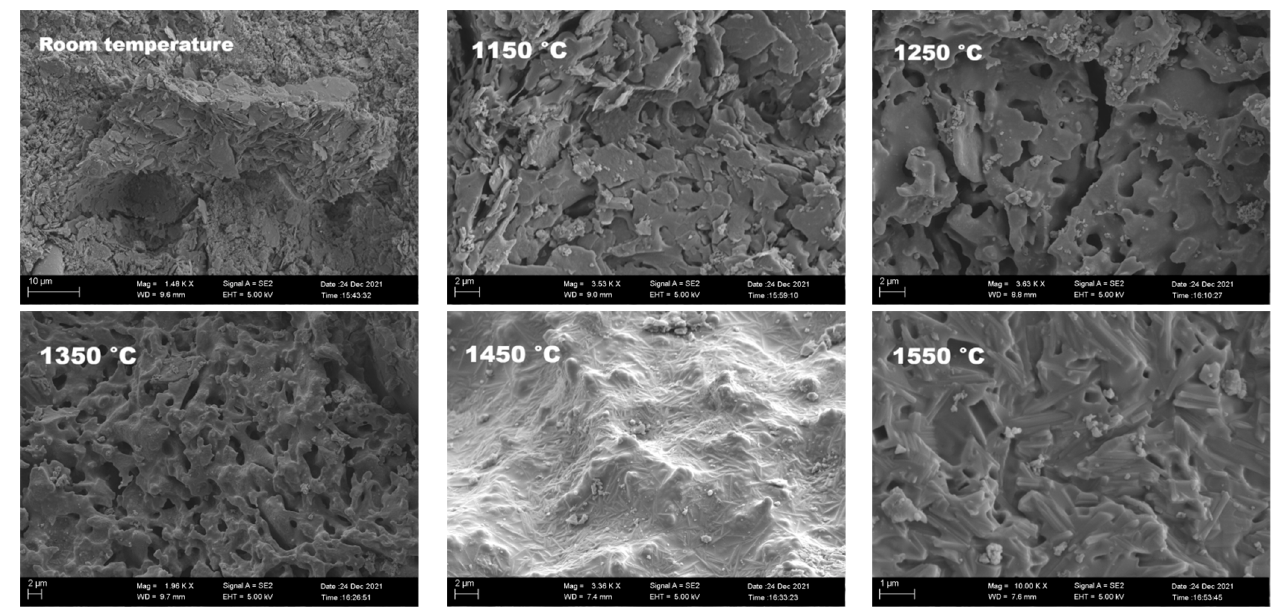
Figure 9. SEM images of samples treated at different temperatures. The heat treatment temperature is indicated on the images.